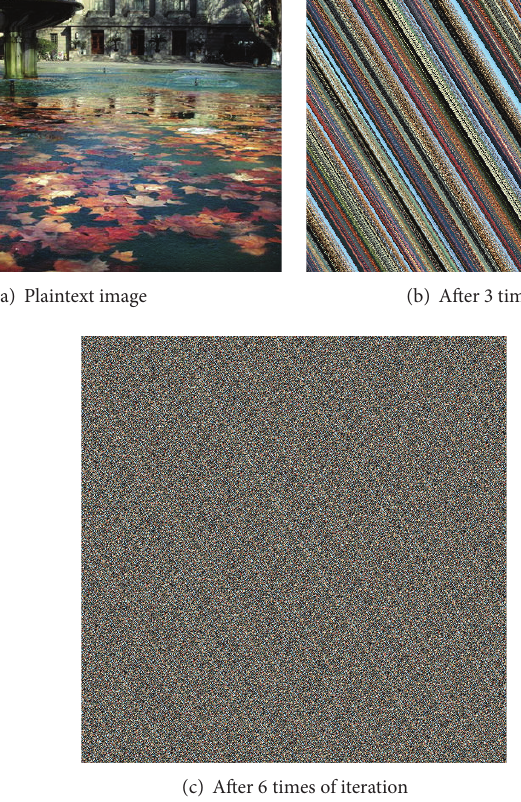
Figure 6: Sample experiment based on Arnold’s Cat